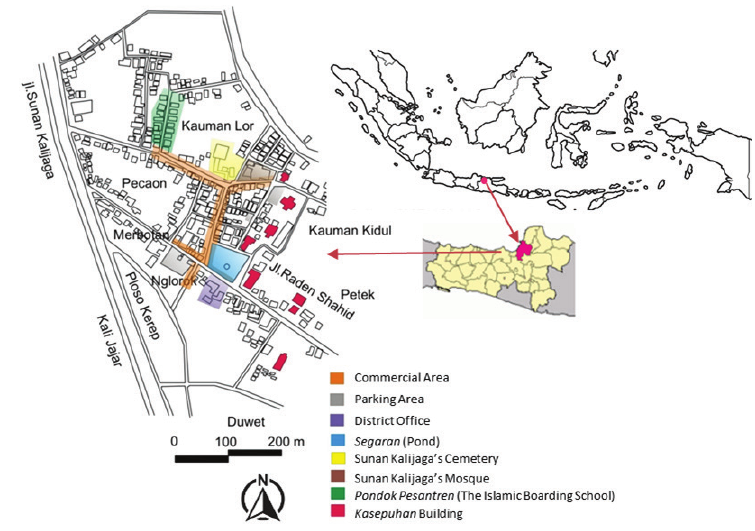
Figure 1. Research location of Kadilangu, Demak (source: processed from Bappeda Demak,